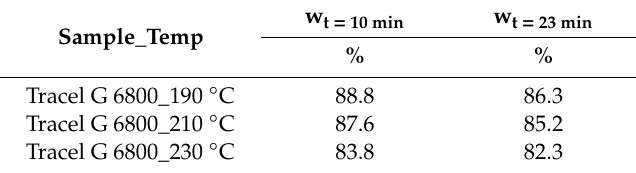
Table 2. The decomposition range of Tracel G 6800 EMS at di ff erent isothermal temperatures.